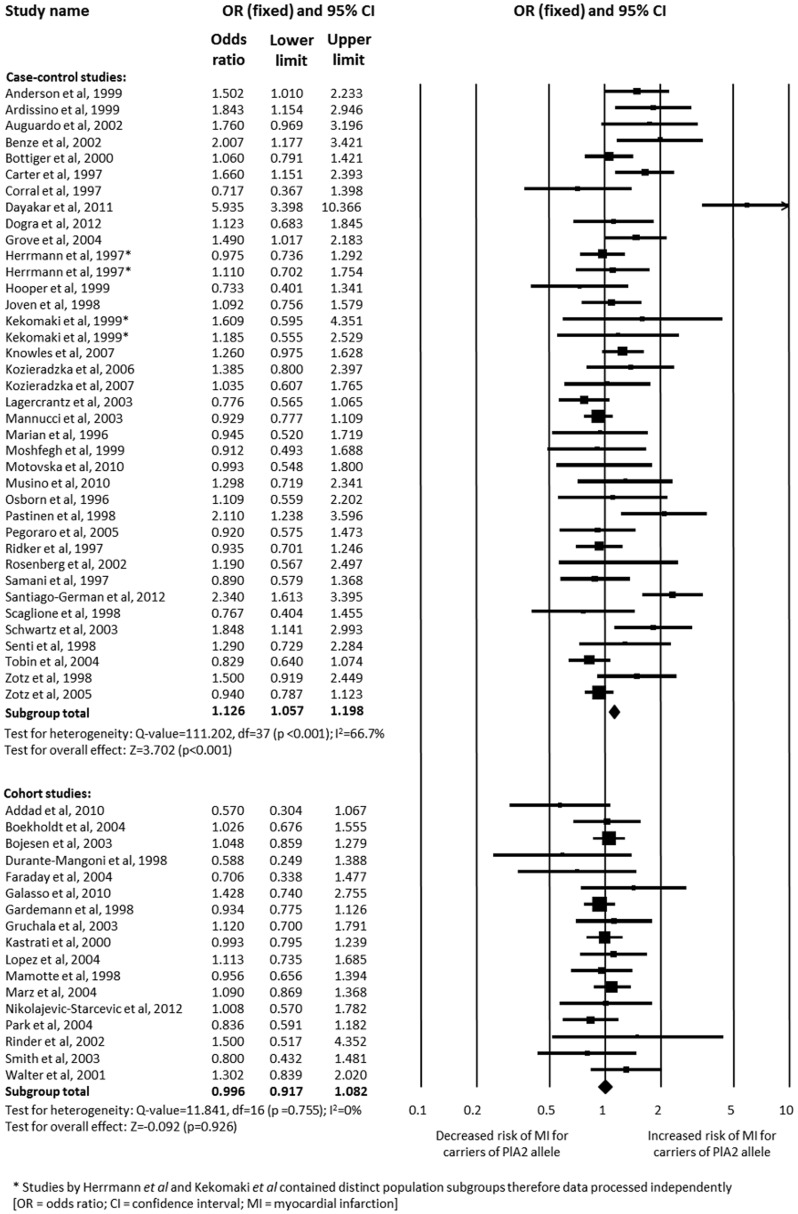
Analysis of the association between carriage of the PlA2 allele and myocardial infarction based on study design.Analysis is of the PlA1/A1 versus PlA1/A2+PlA2/A2 genotype.